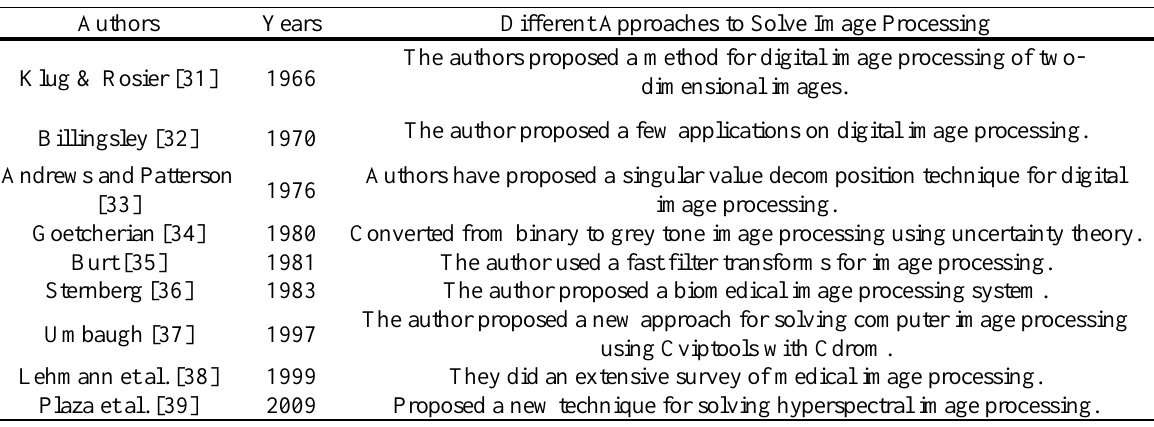
Table 1. A literature review of image processing.